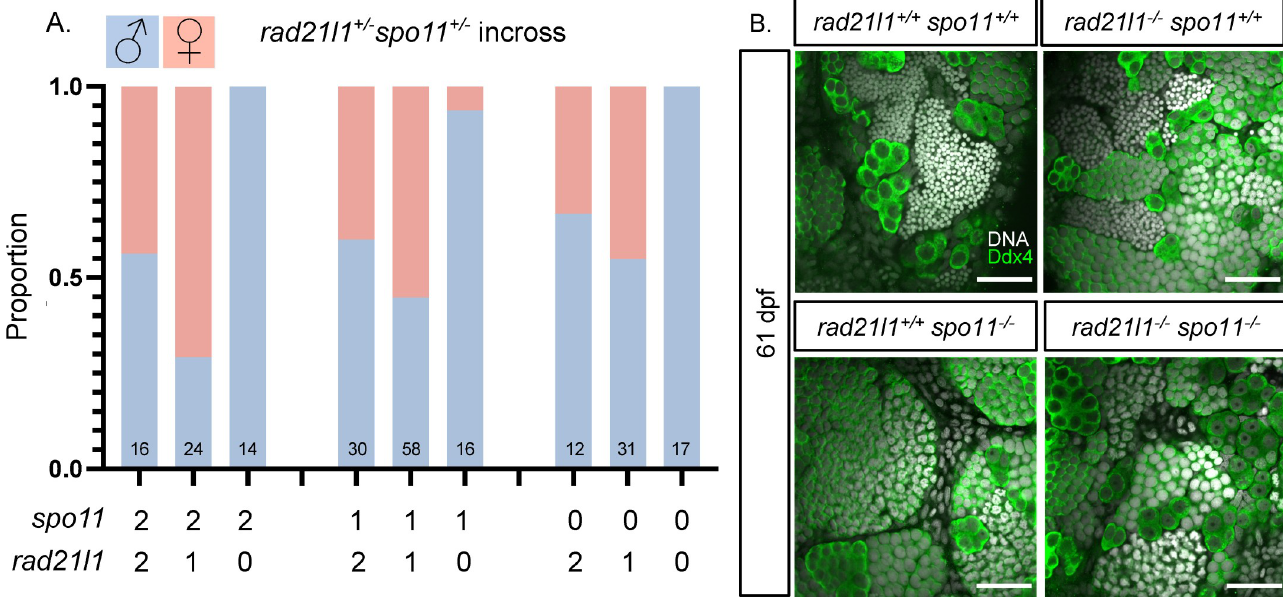
Fig 5. spo11;rad21l1 double mutants are infertile males. (A) Sex ratios of all genotypes resulting from a rad21l1 +/-; spo11 +/- incross. Data pooled from 6 crosses. 0, 1, and 2 on the x-axis refer to the number of wild-type copies of spo11 and rad21l1 . (B) Whole mount testes stained for DNA (gray) and Ddx4 (green). WT and rad21l1 -/-; spo11 +/+ samples display clusters of mature sperm, while rad21l1 +/+ ;spo11 -/- and rad21l1 -/-; spo11 -/- samples do not. Scale bar = 30 μ m.